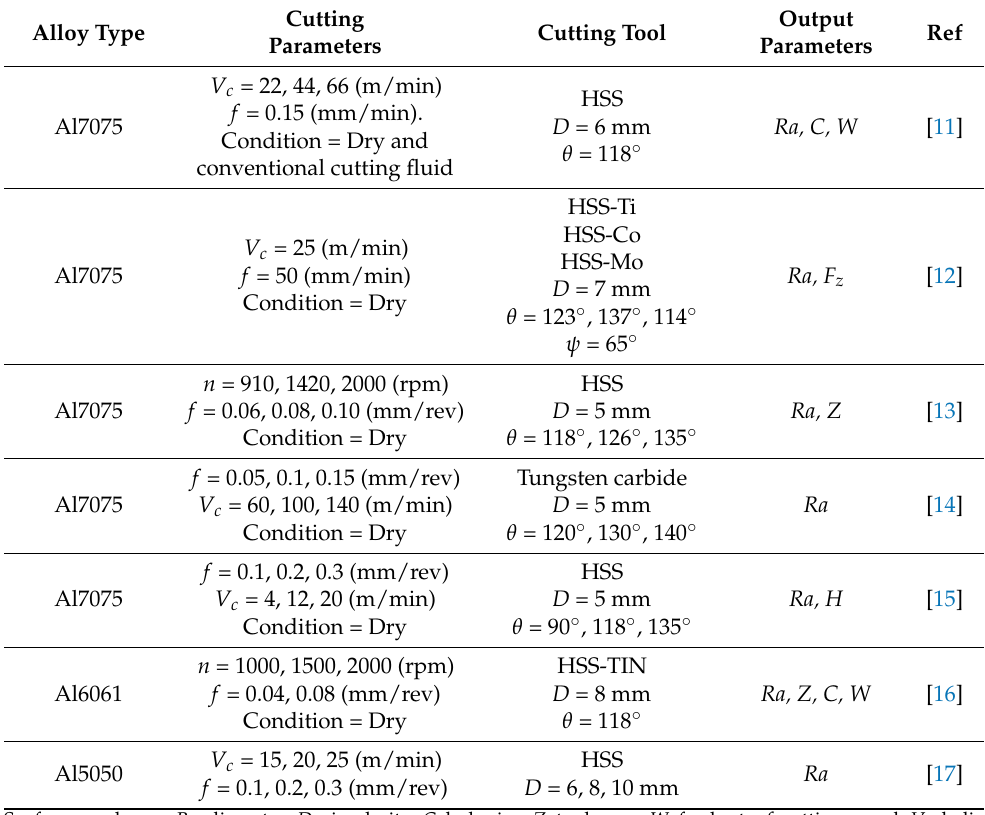
Table 1. Previous studies on drilling of aluminium